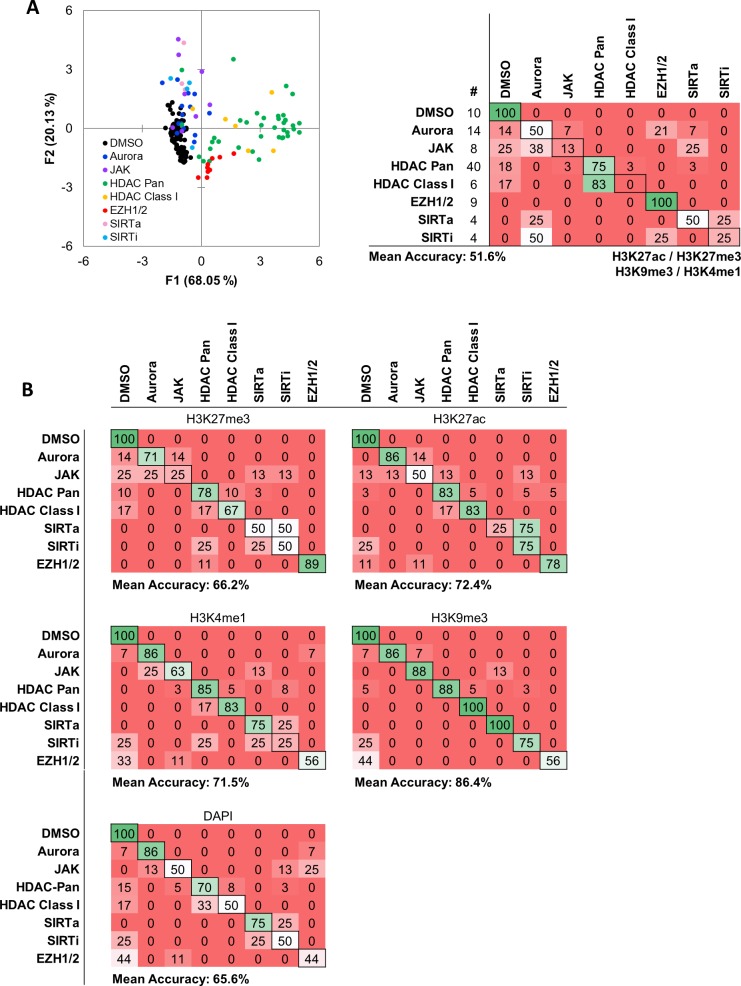
Intensity based functional classification shows reduced classification accuracy compared with MIEL.(A) Quadratic discriminant analysis using average fluorescent intensity derived from images of GBM2 cells treated with either DMSO or 85 active compounds (two technical replicates per compound; 38 DMSO replicates) stained for H3K9me3, H3K27me3, H3K4me1, H3K27ac. Scatter plots depicting the first two discriminant factors derived from features of all four histone modification images for each cell population. Confusion matrix showing classification results of the discriminant analysis. Left column details number of compounds or DMSO replicates for each category in the test set (one replicate per compound). Numbers represent the percent of compounds classified correctly (diagonal) and incorrectly (off the diagonal). (B) Quadratic discriminant analysis using texture features derived from images of GBM2 cells treated with either DMSO or 85 active compounds (two technical replicates per compound; 38 DMSO replicates) stained for H3K9me3, H3K27me3, H3K4me1, H3K27ac or DAPI. Confusion matrix showing classification results from discriminant analysis. Number of compounds or DMSO replicates for each category (one replicate per compound) is as shown in ‘b’. Numbers represent the percent of compounds classified correctly (diagonal) and incorrectly (off the diagonal).